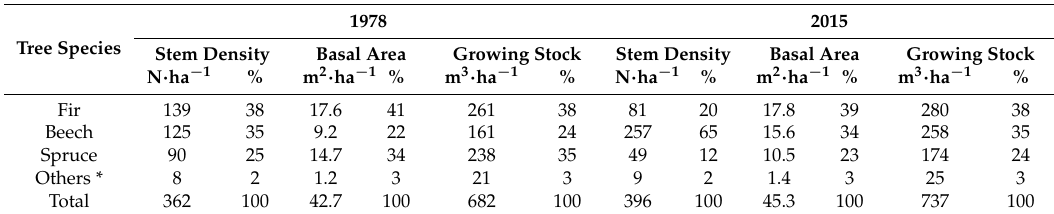
Table 1. Basic stand characteristics of NNR Dobroˇcsk ý prales according to forest inventories in 1978 and